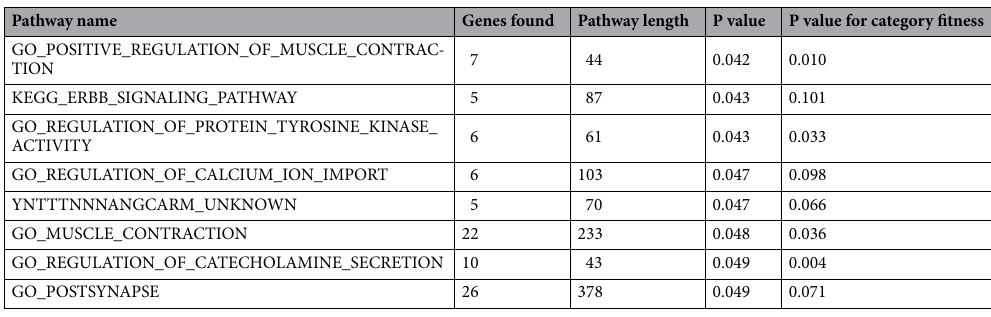
Table 2. Significantly regulated pathways in dimensionality reduction-based pathway analysis of the drug library screen. Pathways with adjusted rounded P values ≤ 0.05 and rounded P values for category fitness ≤ 0.1 are